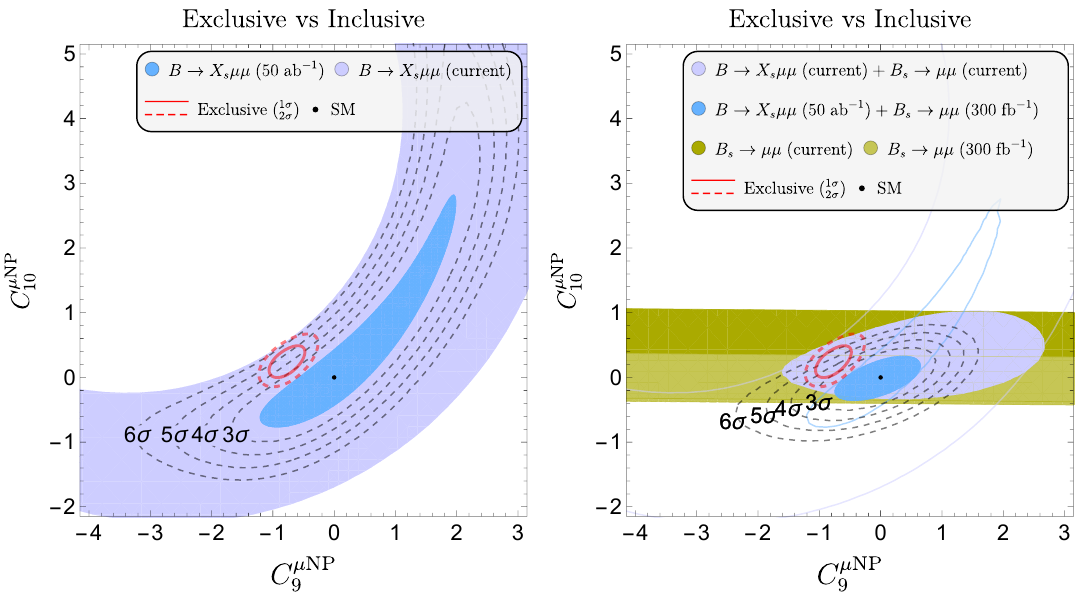
Figure 6 . The expected 50 ab (cid:0) 1 bounds under the assumption C e contour is slightly larger than the one in (cid:12)gure 2 because it corresponds to the muon channel only.